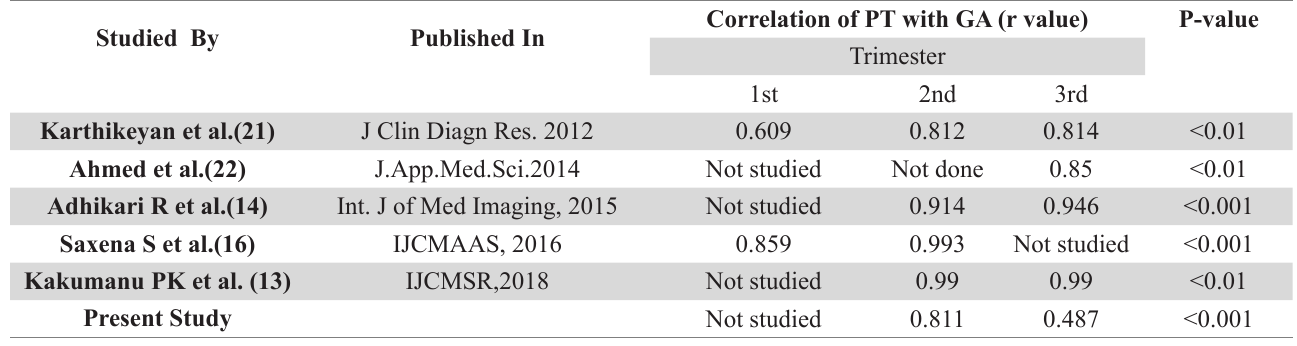
Table 1. Correlation of placental thickness (PT) and gestational age (GA) in various